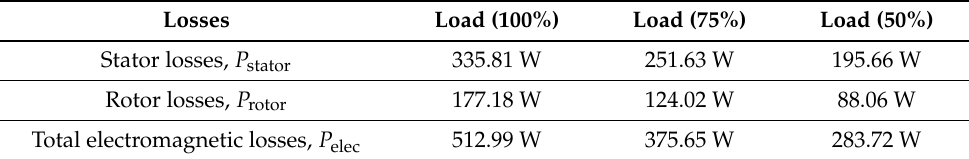
Table 10. Comparison of losses for various load points of the optimal design 3-variable optimiza- tion problem.